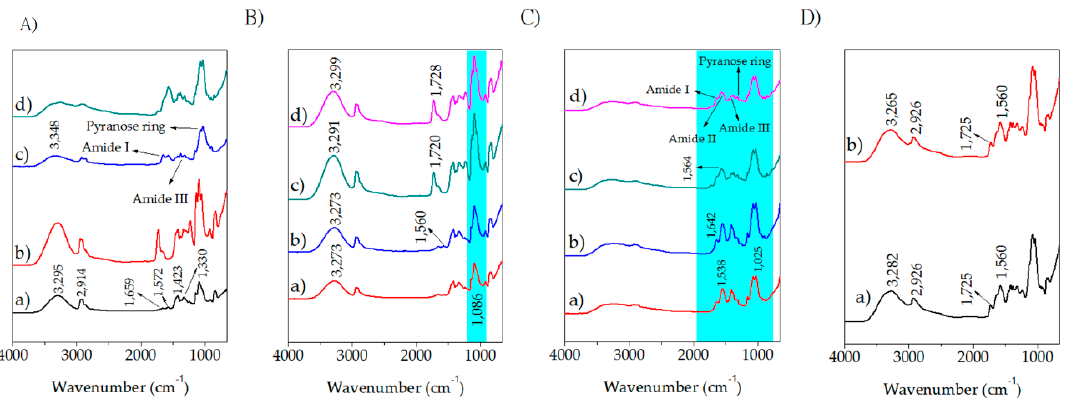
Figure 1. FTIR spectra for BAPS. ( A ). Polymers with and without lactic acid and